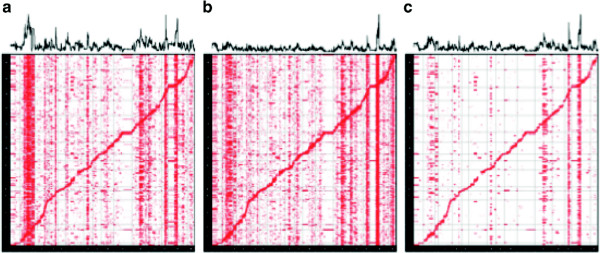
eQTL maps of two versions of a yeast dataset that were generated 3 years apart in different locations. The standard t-test was used to generate the P values. (a) eQTL map of the yeast dataset generated in 2005 [2]. (b) eQTL map of the yeast dataset generated in 2008 [25]. (c) eQTL map using the maximum P value of the two datasets to show the putative genetic associations in the yeast dataset. The graph on the top of each eQTL map shows the strength of regulatory hotspots as the average over all genes of the − logP values for a given SNP.